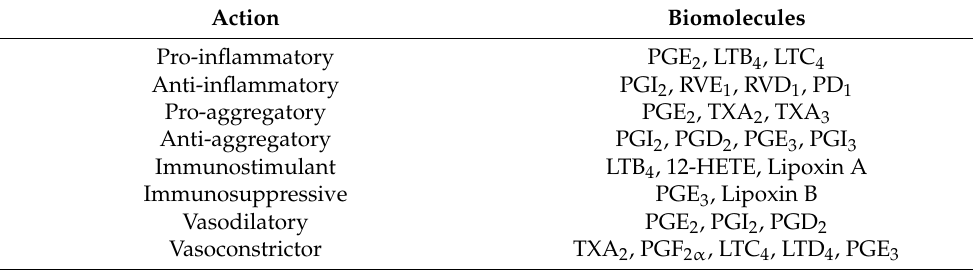
Table 2. Physiological actions of main eicosanoids and docosanoids